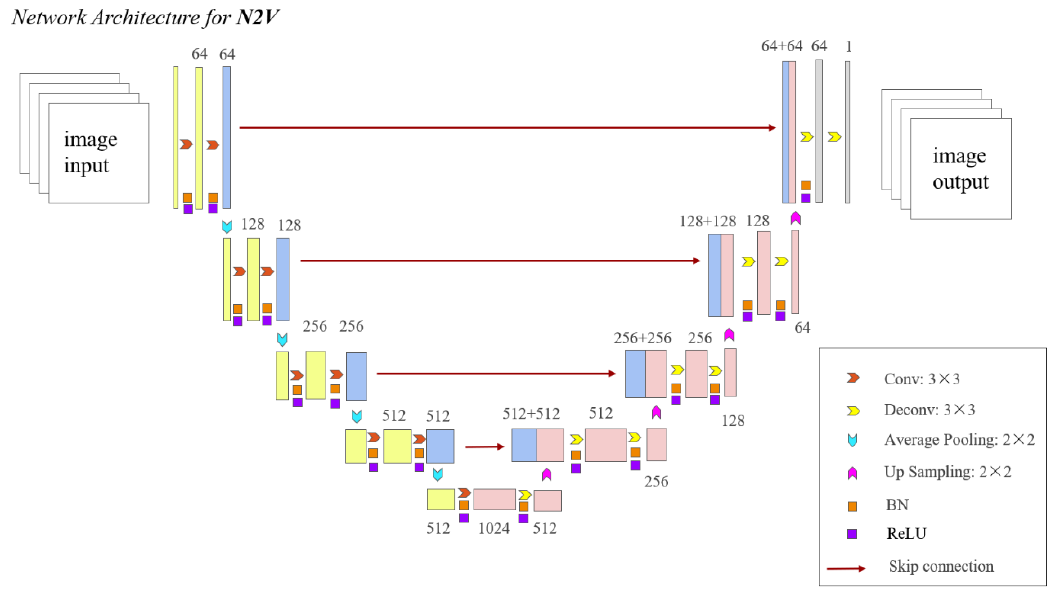
Figure 2. The network architecture of N2V network. Abbreviations: Conv, convolution; Deconv, deconvolution; BN, batch normalization; ReLU, rectified linear unit.